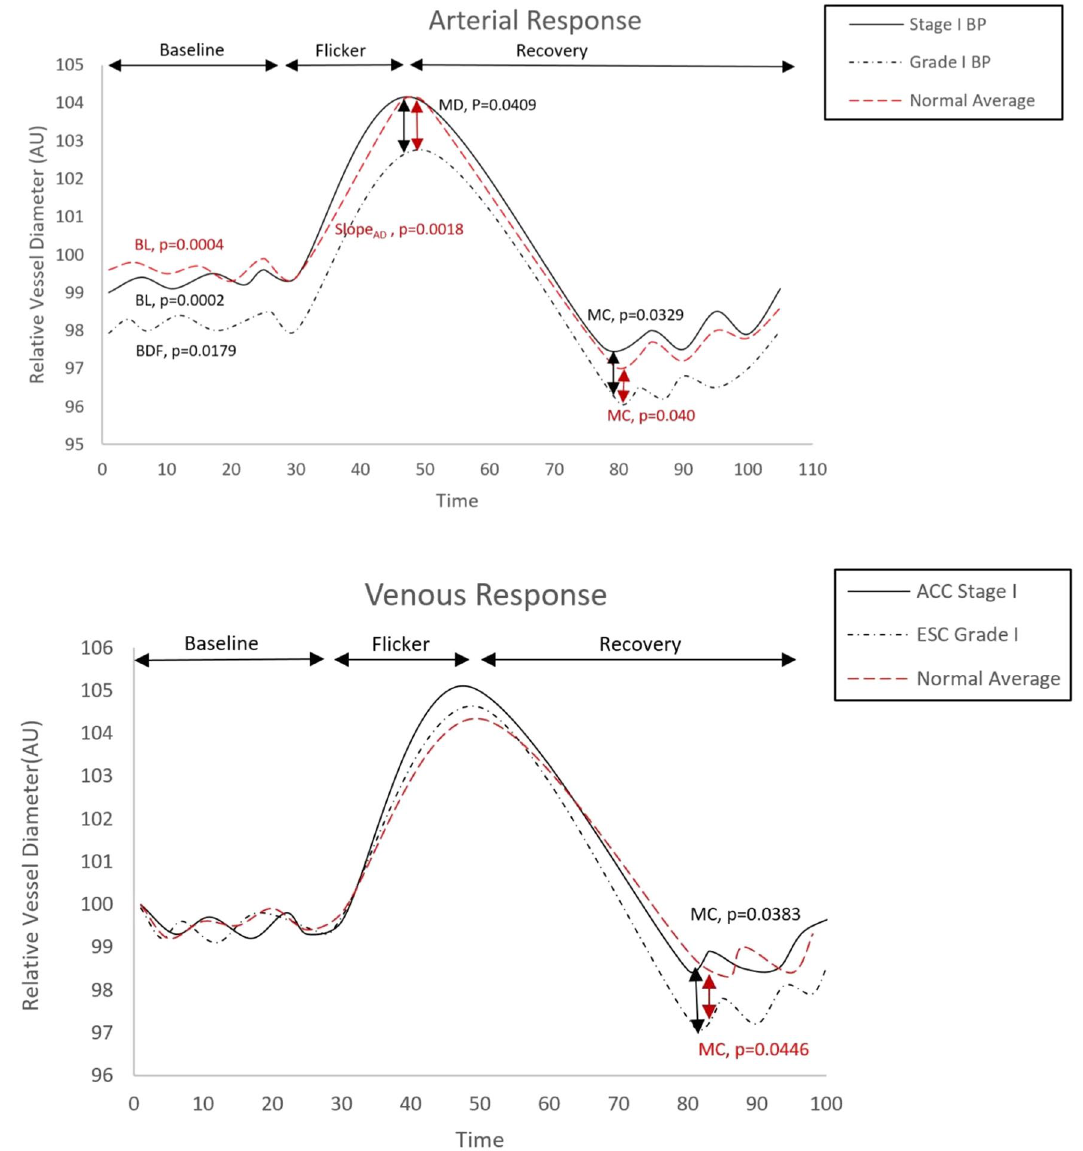
Figure 3. Comparison of retinal arterial and venous response profile across groups. AU, arbitrary units; BDF, baseline diameter fluctuation calculated as the maximum range in vessel diameter during first 30 s of baseline readings; MD%, calculated as the percentage change in vessel diameter from baseline to maximum following onset of flicker; tMD, time to reach maximum diameter during flicker; tMC, time to reach maximum constriction post flicker; slope AC & Slope VC , calculated as